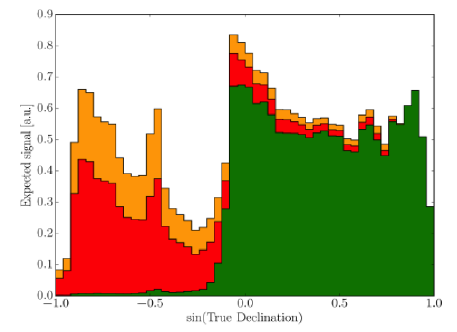
Figure 3. Relative contribution to the sensitivity to the galactic plane using ANTARES tracks (red), ANTARES showers (orange) and IceCube tracks (green) as a function of